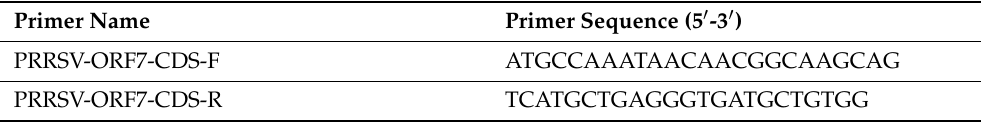
Table 4. Primers used for RIP